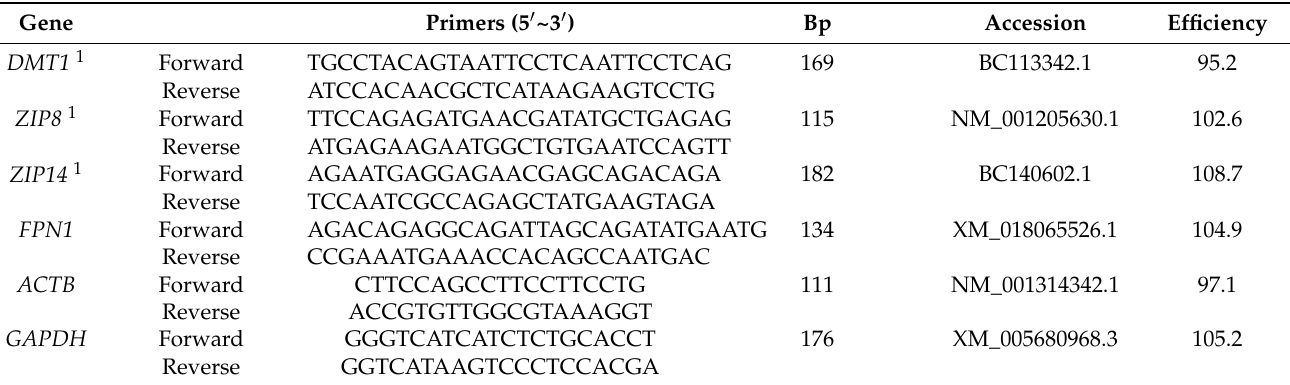
Table 2. Primer sequences and amplicon